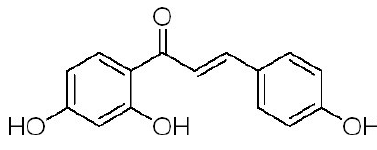
Figure 1. The chemical structure of